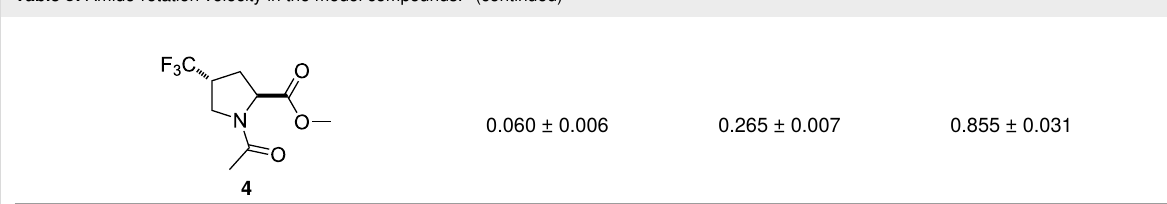
Table 3: Amide-rotation velocity in the model compounds. a (continued)